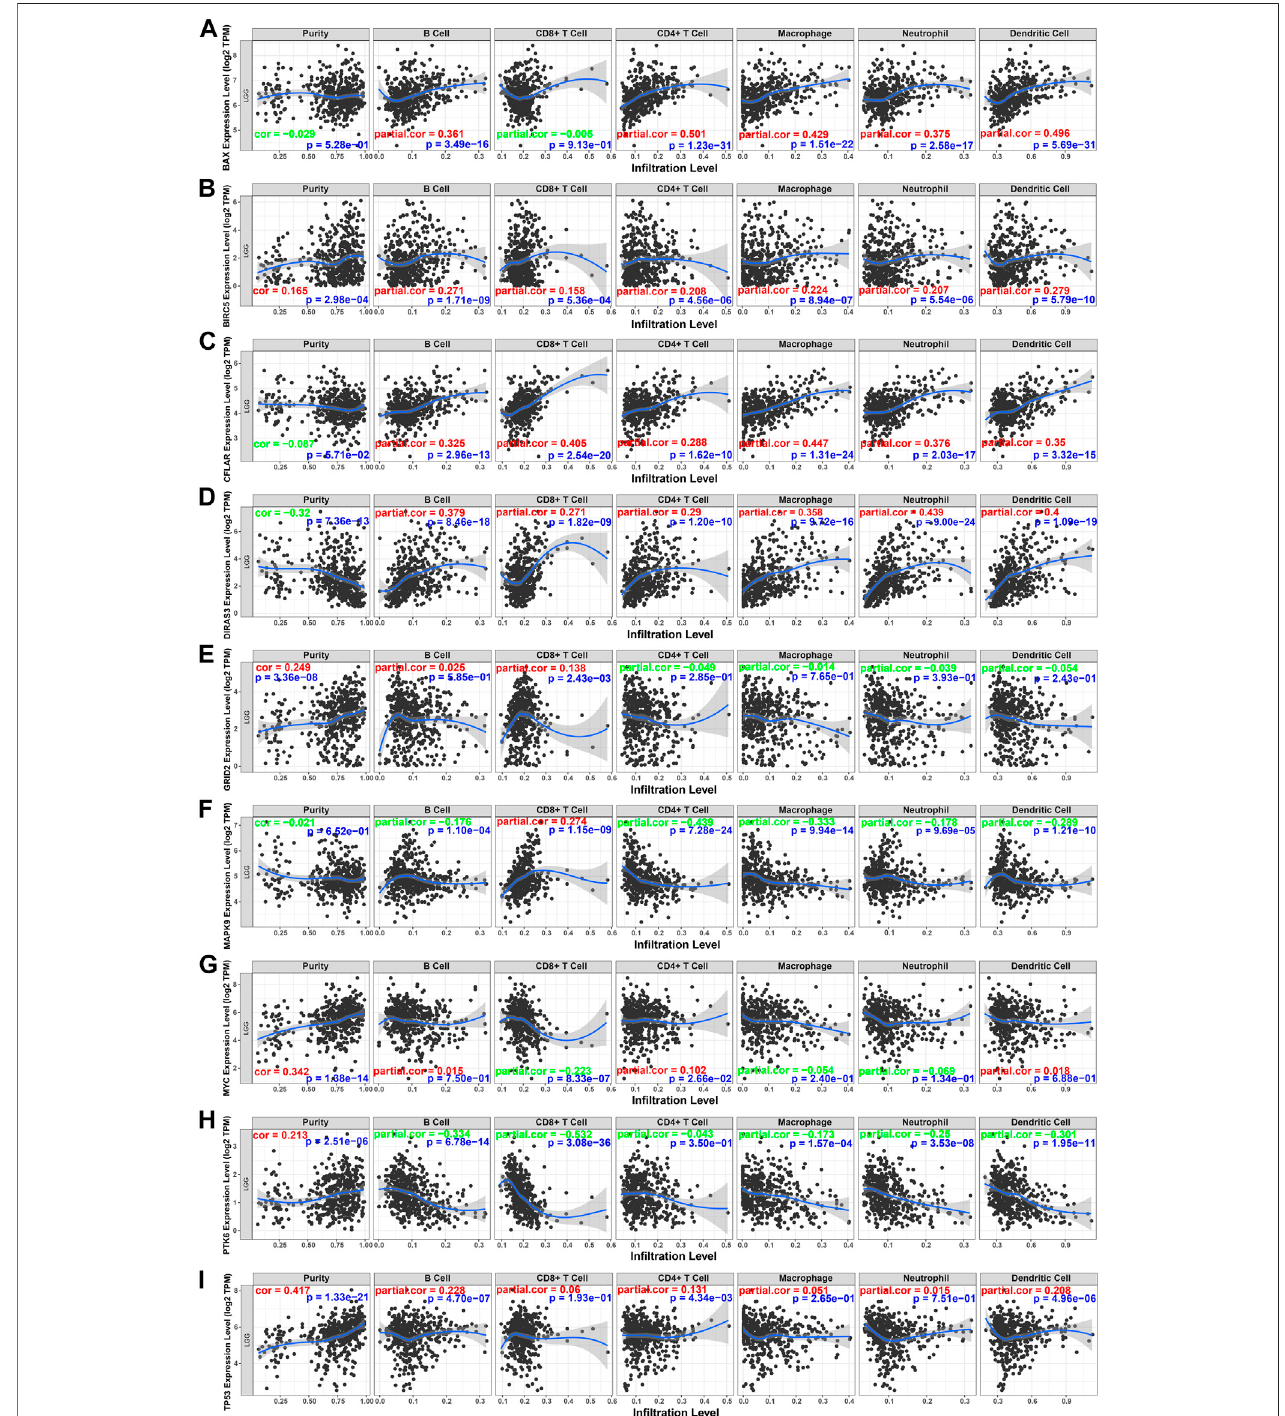
FIGURE10| Relationsbetweenimmunecellsandprognosticgenes. (A) BAXexpressionlevelandimmunecellsinlow-gradeglioma; (B) BIRC5andimmunecells; (C) CFLAR and immune cells; (D) DIRAS3 and immune cells; (E) GRID2 and immune cells; (F) MAPK9 and immune cells; (G) MYC and immune cells; (H) PTK6 and immunecells; (I) TP53.TPM:transcriptsperkilobasemillion.Theredcolorinthecorrelationcoef fi cientrepresentsapositivecorrelation,andthegreencolorrepresentsa negative correlation.